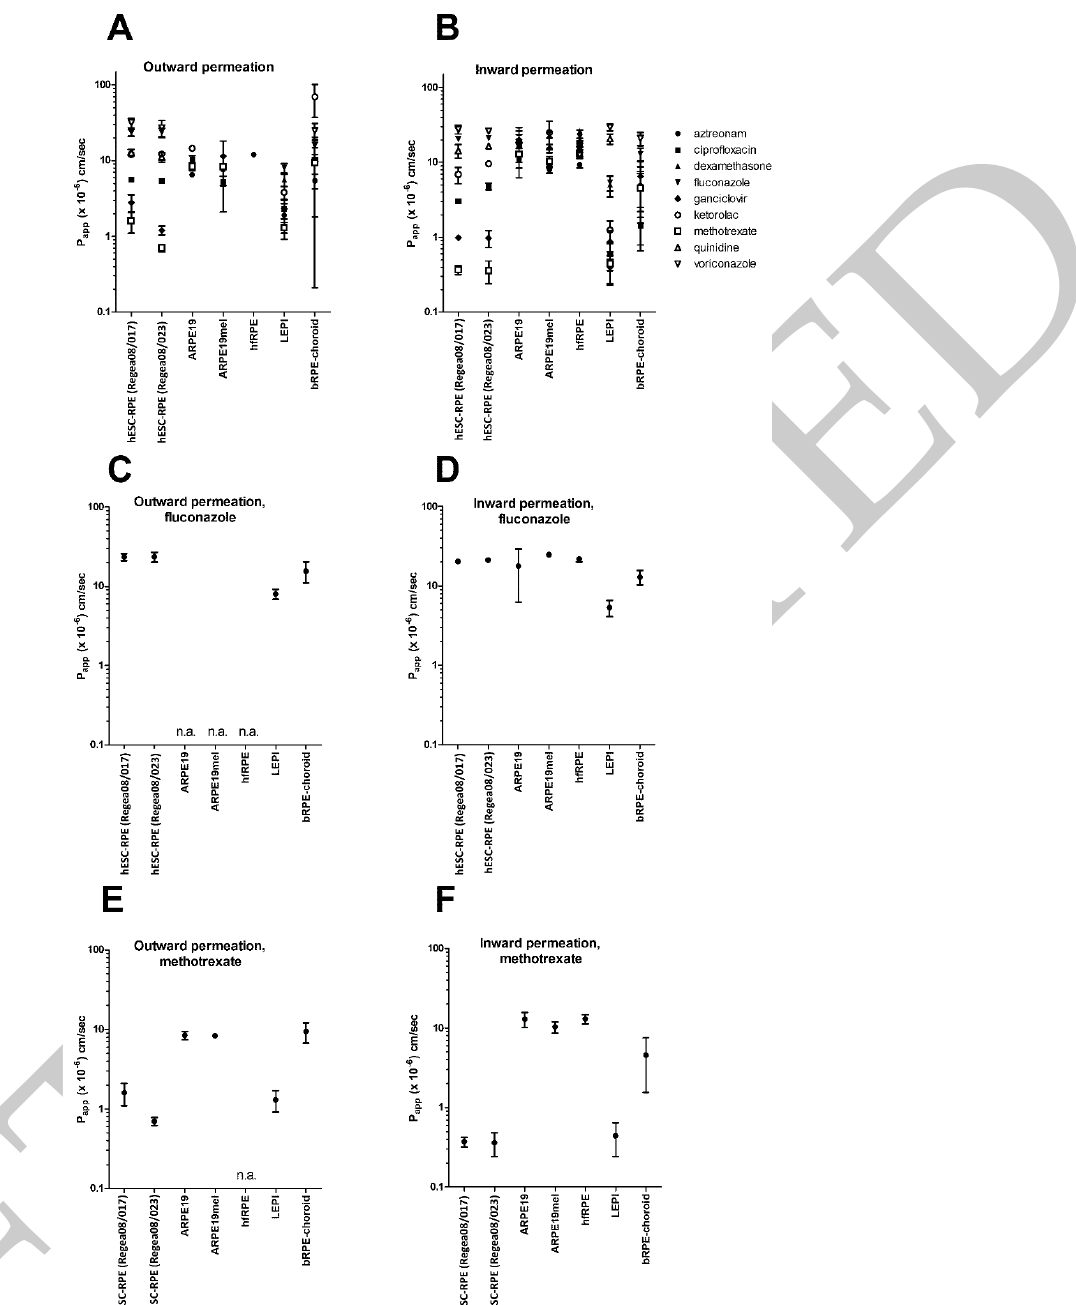
Figure 1. The studied retinal pigment epithelial (RPE) cell models display clear differences in their barrier properties. Both the outward ( A ) and inward ( B ) permeation of the drugs in ARPE19, ARPE19mel, and hfRPE cells lay in a narrow range, whereas in hESC-RPE and LEPI cells, there was a wide range of P app values, similar to the situation in the bovine RPE-choroid (values from [2]). P app values of the lipophilic drug fluconazole were similar among all the studied RPE models, indicating transport via a passive transcellular permeation route ( C , D ). The largest differences were observed in the permeation of the hydrophilic compound methotrexate ( E , F ), which displayed high permeation across ARPE19, ARPE19mel, and hfRPE cells, whereas in hESC-RPE cells, LEPI cells, and bovine RPE-choroid, its permeation was restricted more efficiently. n = 2–9, see Supplementary material for details. Abbreviations: n.a., not applicable (drug flux was too rapid for reliable P app value determination: more than 10% of the compound permeated within 60